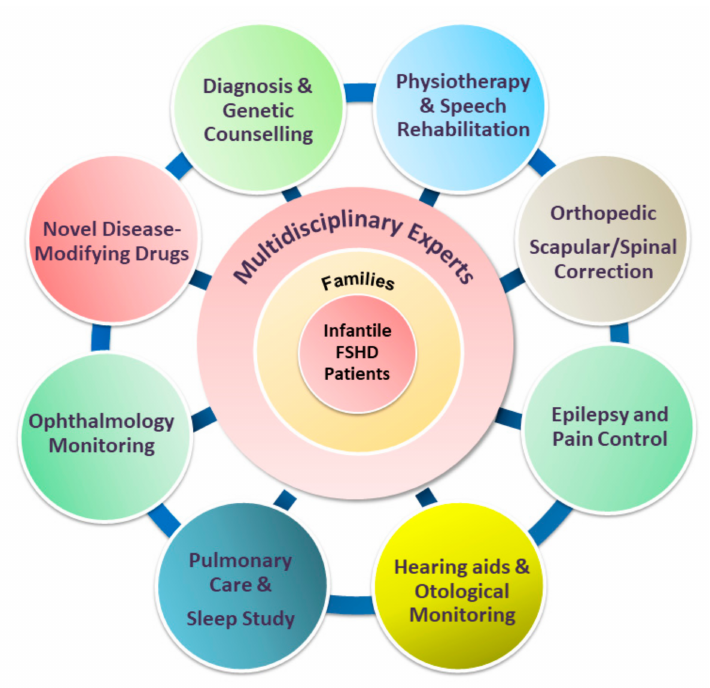
Figure 4. The paradigm of multidisciplinary care of infantile FSHD, incorporating disease-modifying therapies with the standard of care (SOC). Novel disease-modifying agents and evolving multidisciplinary supportive management need to occur concomitantly to achieve the best possible outcome for patients with infantile FSHD. Implementation of comprehensive SOC also plays a critical role in drug development because it may eliminate the variability of treatment outcomes due to variable care